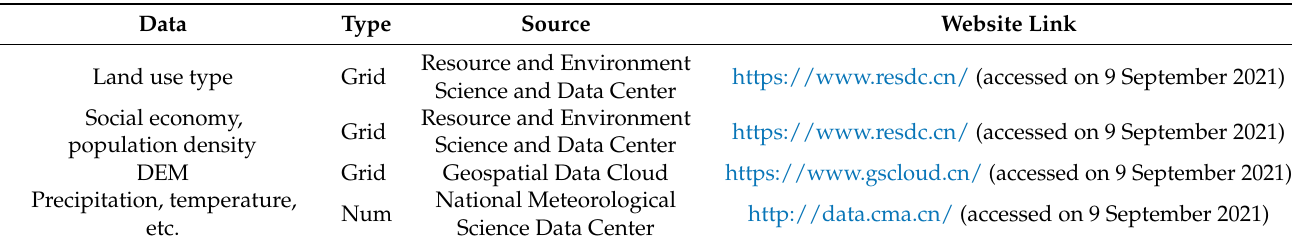
Table 1. Required data and sources.